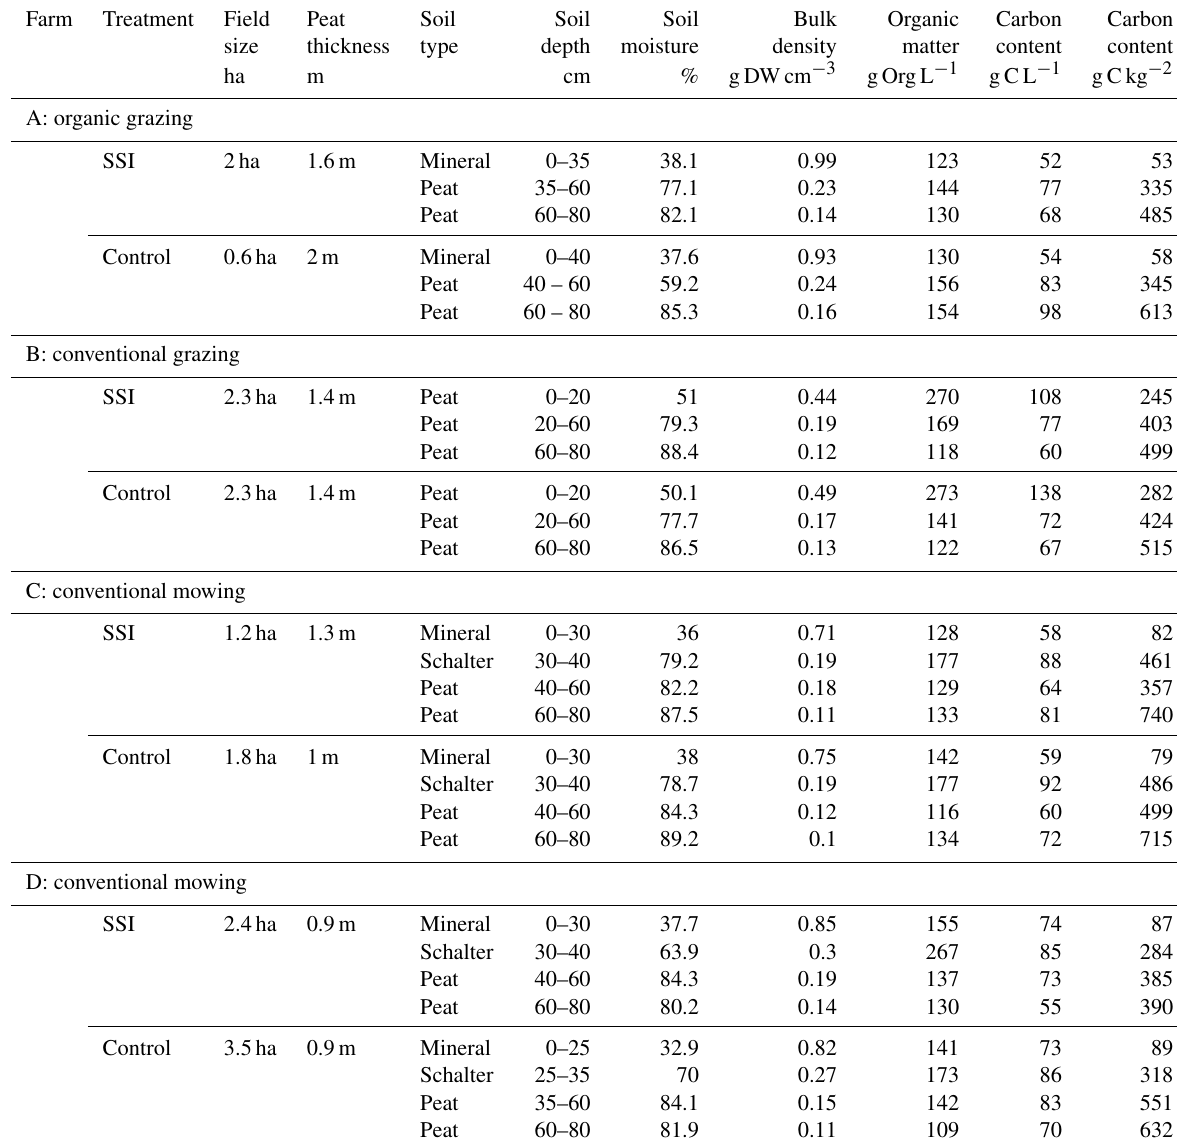
Table 1. Soil and land-use characteristics of the research sites in the Frisian peat meadows, the Netherlands. Averages per soil type, gravi- metric soil moisture content taken August 2017, dry weight (DW) bulk density, organic matter content and elemental carbon